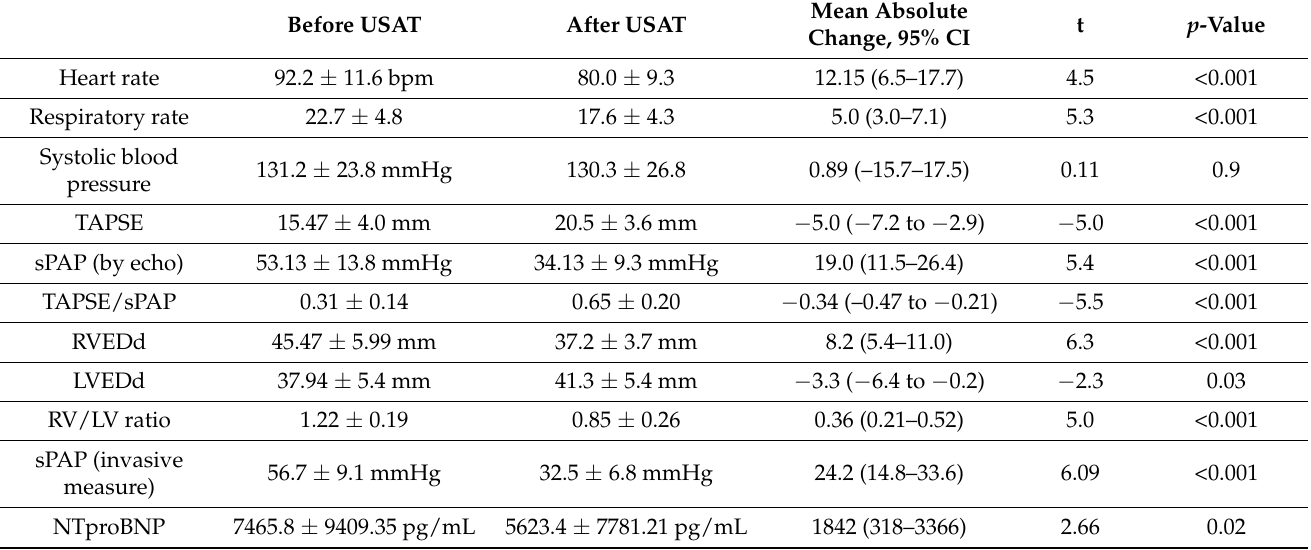
Table 4. Mean values before and after therapy. USAT: ultrasound-accelerated thrombolysis, CI: confidence interval, TAPSE: tricuspid annular plane systolic excursion, sPAP: systolic pulmonary artery pressure, RVEDd: right ventricle end-diastolic diameter, LVEDd: left ventricle end-diastolic diameter, RV/LV ratio: right ventricle to left ventricle diameter ratio, NTproBNP: N-terminal pro- brain natriuretic